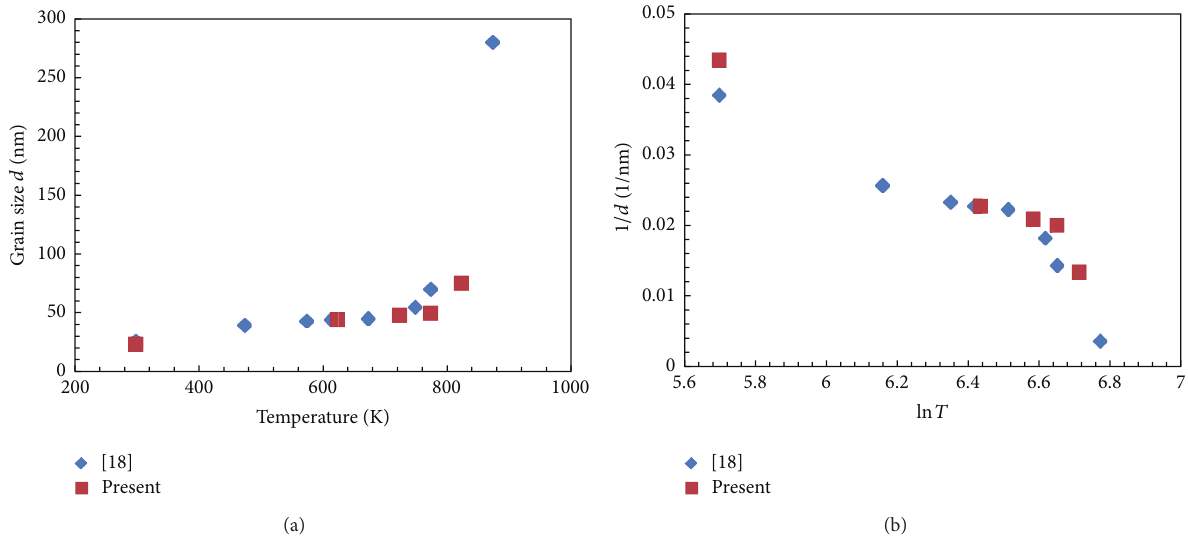
Figure 12: (a) Correlation between the grain size, d (nm) and Temperature (K) and (b) relation between 1/ 𝑑 and ln 𝑇